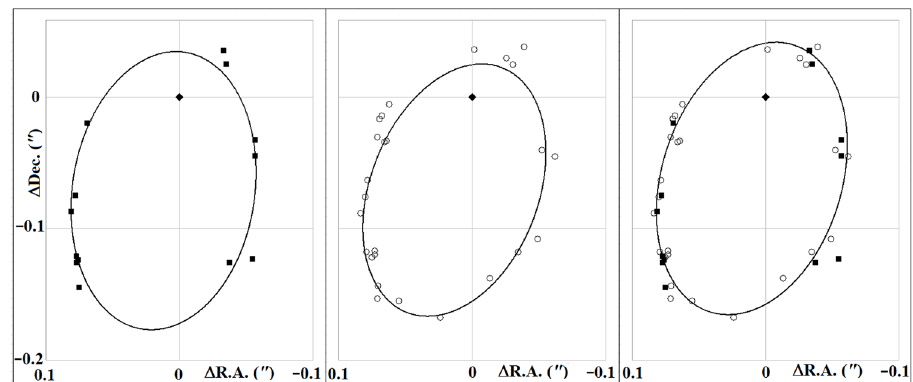
Figure 2: Orbits of